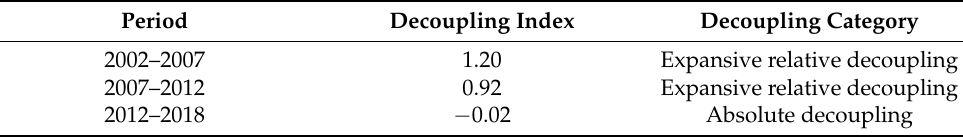
Table 1. Decoupling index and category from 2002 to